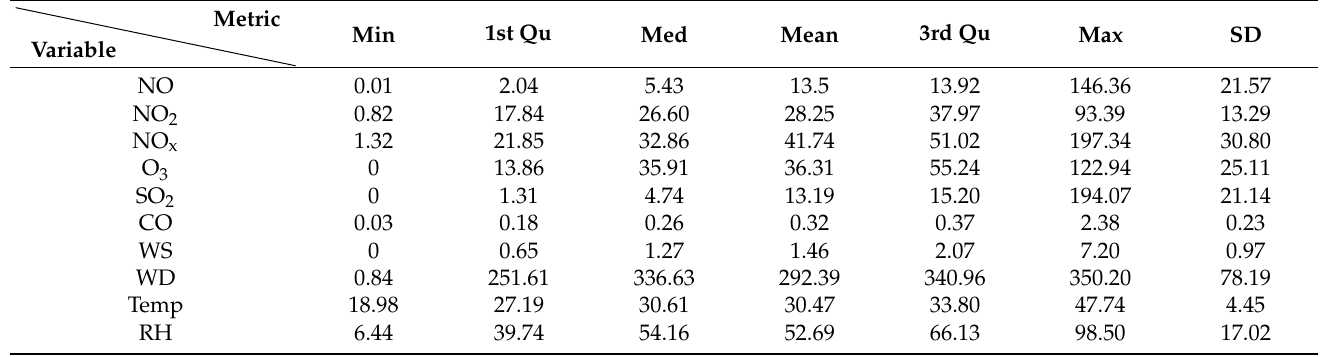
Table 2. Summary of the air pollutants and meteorology data for 2018–2019. All of the pollutants were measured in ppb, except for CO, which was measured in ppm. In the table, WS stands for wind speed (m/s), WD for wind direction (degree from the north), Temp for temperature ( ◦ C), and RH for relative humidity